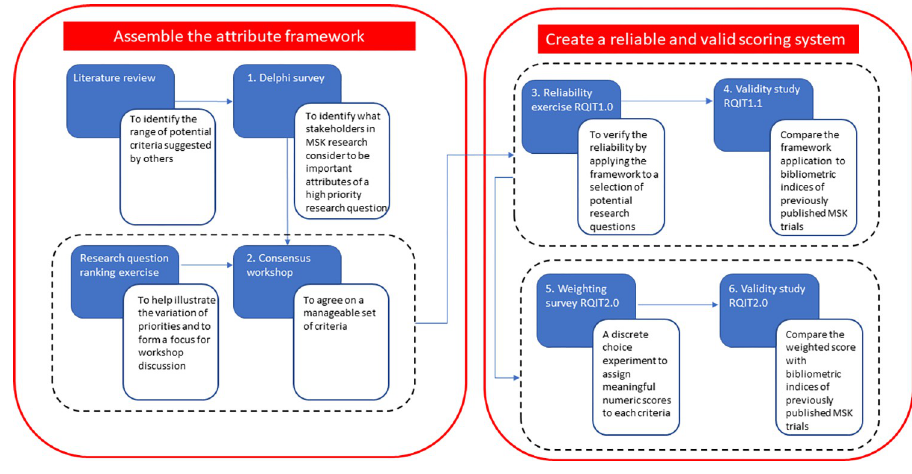
Fig 1. A schematic of the overall study